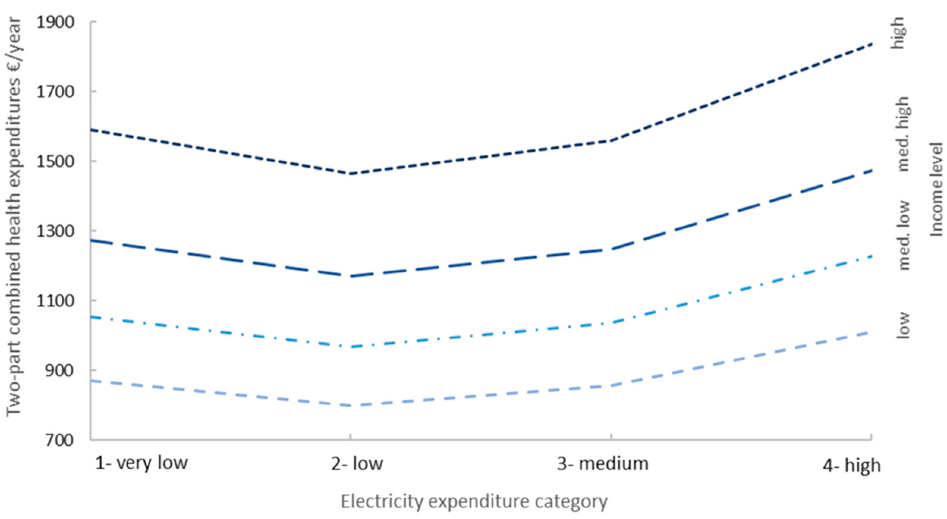
Figure 7. AAP for health expenditures by electricity expenditure and income level.